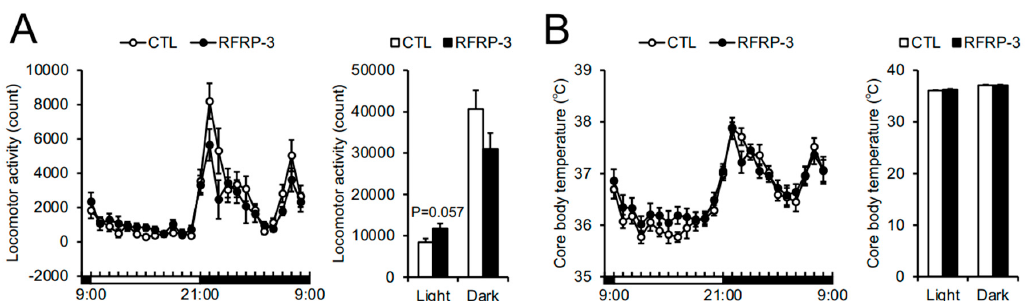
Figure 4. The effects of chronic intracerebroventricular (i.c.v.) infusion of RFamide-related peptide-3 (RFRP-3) on O 2 / CO 2 metabolism and core body temperature every 15 min. ( A ) O 2 consumption (VO 2 ) measured in the metabolic cage. ( B ) CO 2 production (VCO 2 ) measured in the metabolic cage. ( C ) Energy expenditure calculated by VO 2 and VCO 2 . ( D ) The core body temperature measured by the implanted temperature data logger. Each value represents the mean ± standard error of the mean. n = 7–8; * p < 0.05, ** p < 0.01, *** p < 0.005.